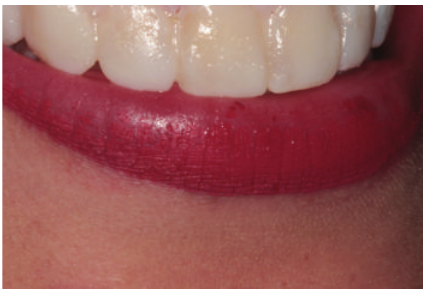
Figure 4: Mock-up made with bis-acryl resin.